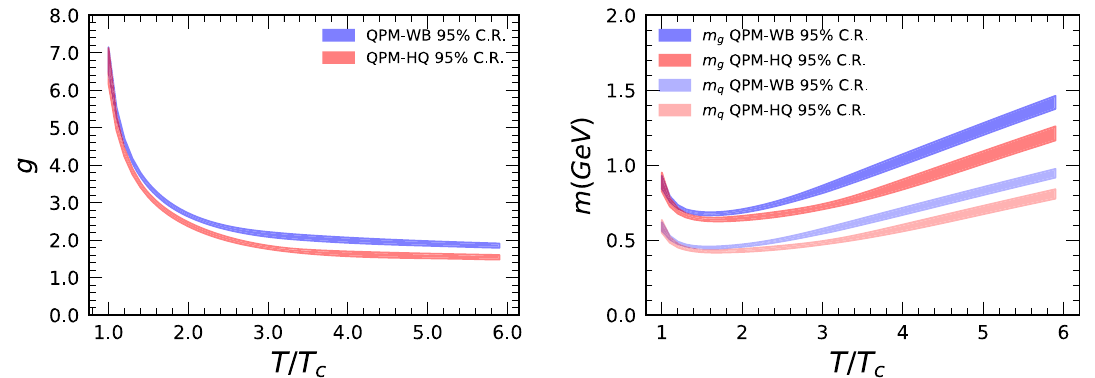
Fig. 3 The strong coupling g ( T ) (Left) and quasi-particle masses m ( T ) (Right) using the fitted parameter values from the Bayesian analysis